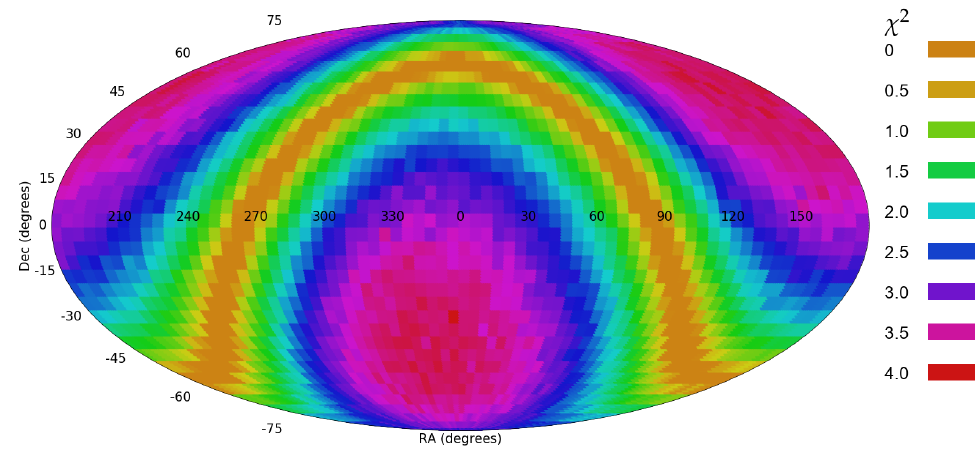
Figure 12. The χ 2 probability of a dipole axis in spin directions when each galaxy in the dataset is